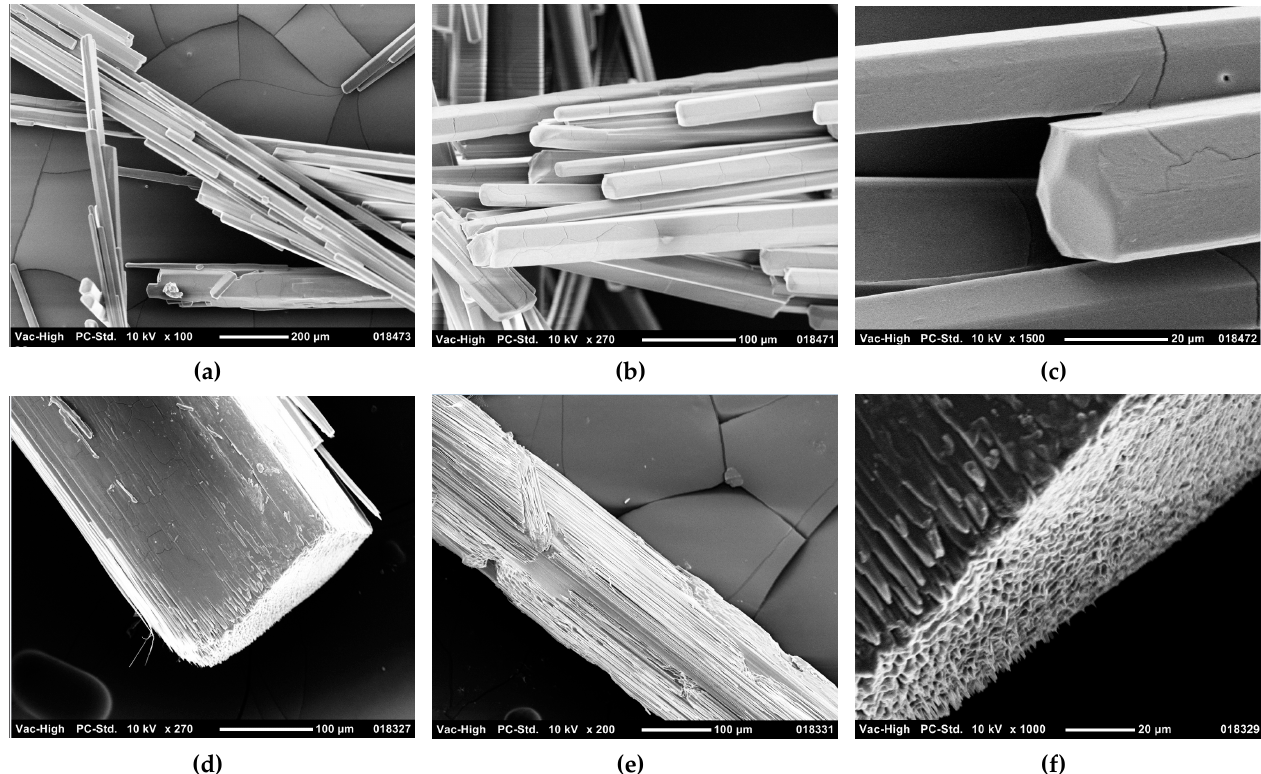
Figure 6. ( a – c ): SEM photographs of pure S-IBU/S- α MBA. ( d – f ): SEM photographs of ss-S-IBU/S- α MBA at the limit of the solid solution (X R-IBU/S- α MBA = 14%). Pure salt is smooth and has a regular shape, whereas the salt with solid solution is rough due to a visible association of fibers. Some cracks are observed on the two samples.